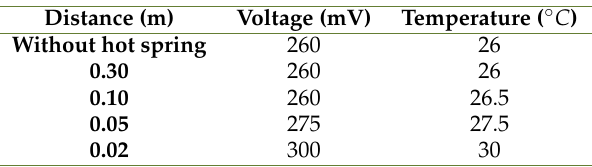
Table 2. LM35 sensor test results